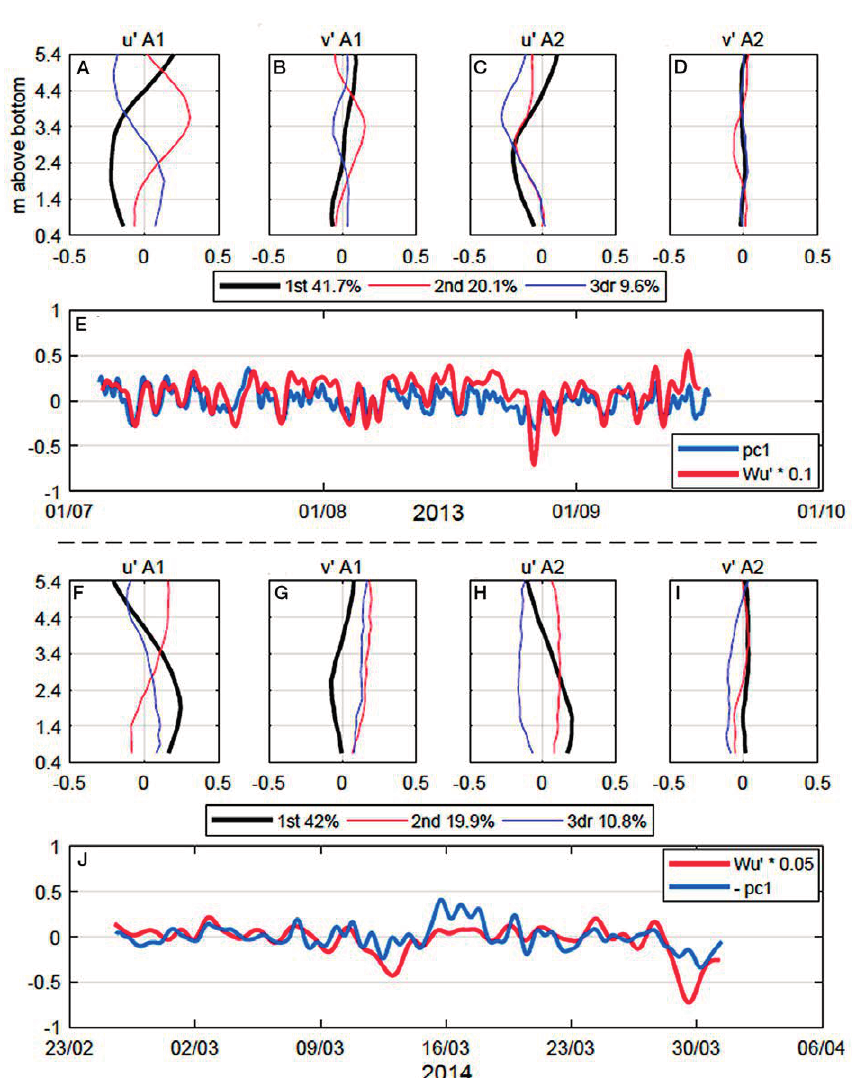
Fig 6. – EOF analysis for low-frequency filtered data (Lanczos low-pass band filter of 30 h) in summer (upper panels) for A1 and A2 along- shore (A and C) and cross-shore (B and D) currents. The legend shows the corresponding percentage of the explained variability. The time evolution for the first component (pc1) is shown in image E, compared with the filtered alongshore wind in red (corrected by factor of 0.1 to improve graphical representation). Images F-J show the same for